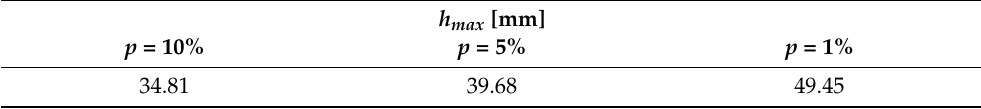
Table 2. Amount of forecasted rainfall.